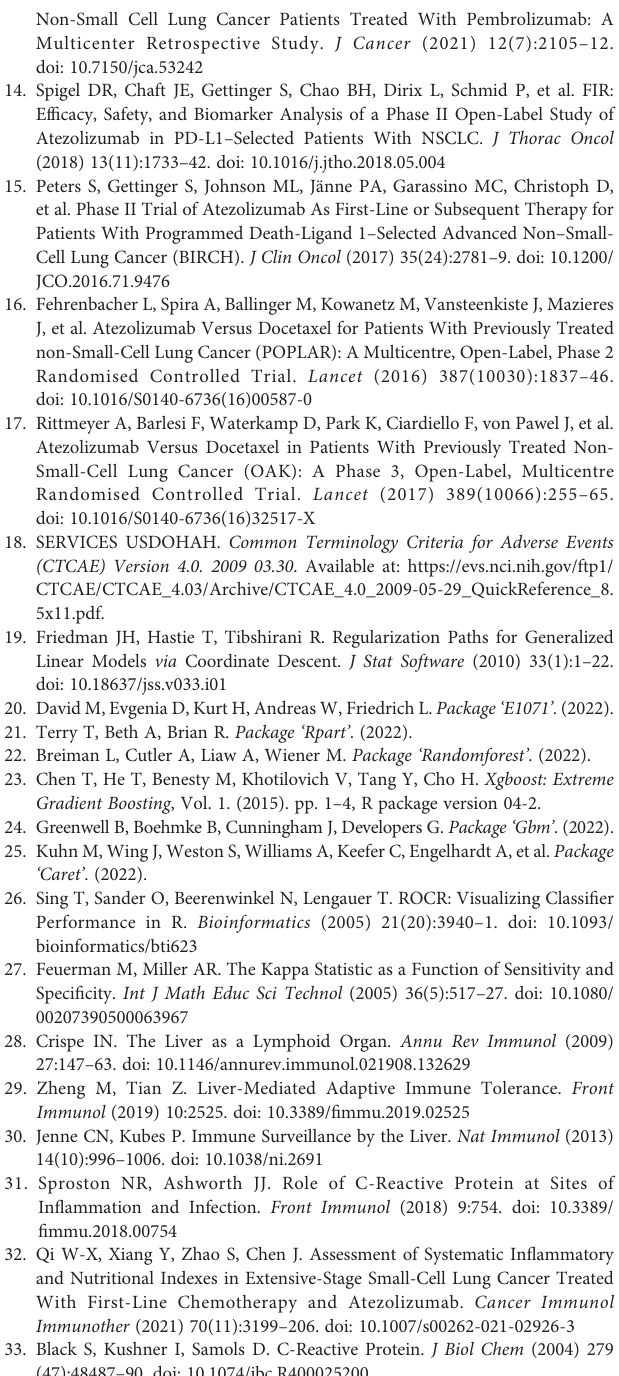
Supplementary Table 1 | Summary of AUC distribution. AUC was calculated by 7machinelearningmethodsfrom1,000simulationsofthetrainingandtestdatasets at 8:2, 7:3 and 6:4 cohort ratios randomly selected from the combined cohort comprising 1,320 atezolizumab-treated NSCLC patients. Supplementary Table 2 | Summary of ANOVA and Tukey HSD tests of the 3 biomarker panels of this study. ANOVA and Tukey HSD tests were performed on the AUC calculated by 7 machine learning methods from 1,000 simulations of the